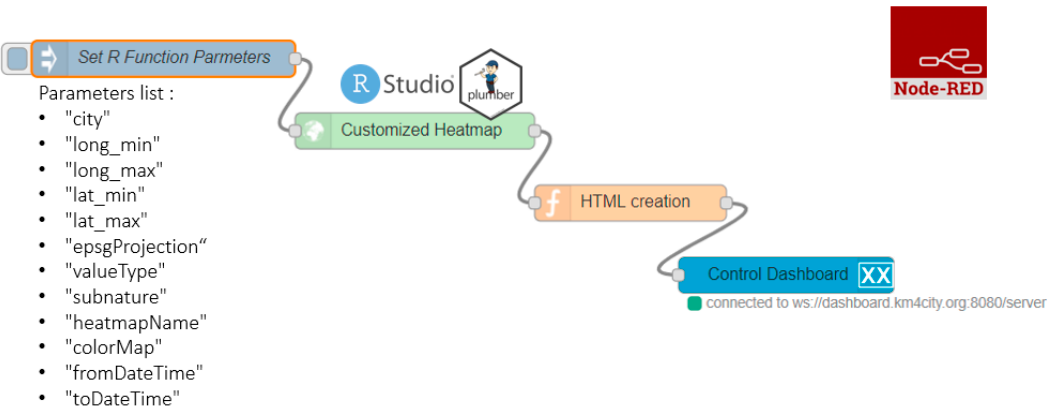
Figure 13. Node-RED workflow for automatization of heatmap production.